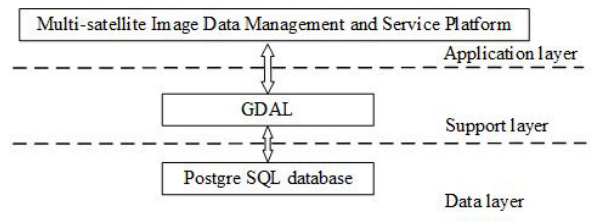
Figure 1.Overall technical framework